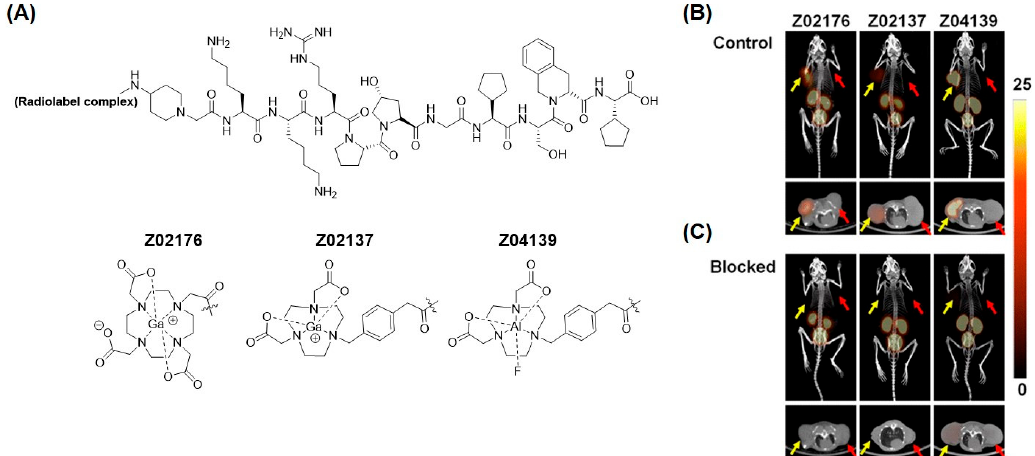
Figure 8. Optimization of B1R radiopharmaceuticals . ( A ) Chemical structure of B1R radioligands. ( B ) Representative 1 h post-injection MIP (maximum intensity projection) and axial PET/CT images of radiolabeled Z02176, Z02137, and Z04139 in mice bearing both B1R+ (indicated by yellow arrows) and B1R– (indicated by red arrows) tumors without and ( C ) with co-injection of 100 µg cold standard. The displacement in tumor uptake demonstrates target specificity of the imaging agent. The scale bar is in units of %ID/g. Figure reproduced from Zhang, Z.; et al. [82].